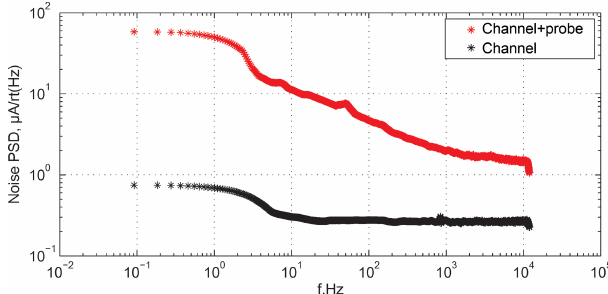
Table 3. Specification of the current probe (A622 from Tektronix).